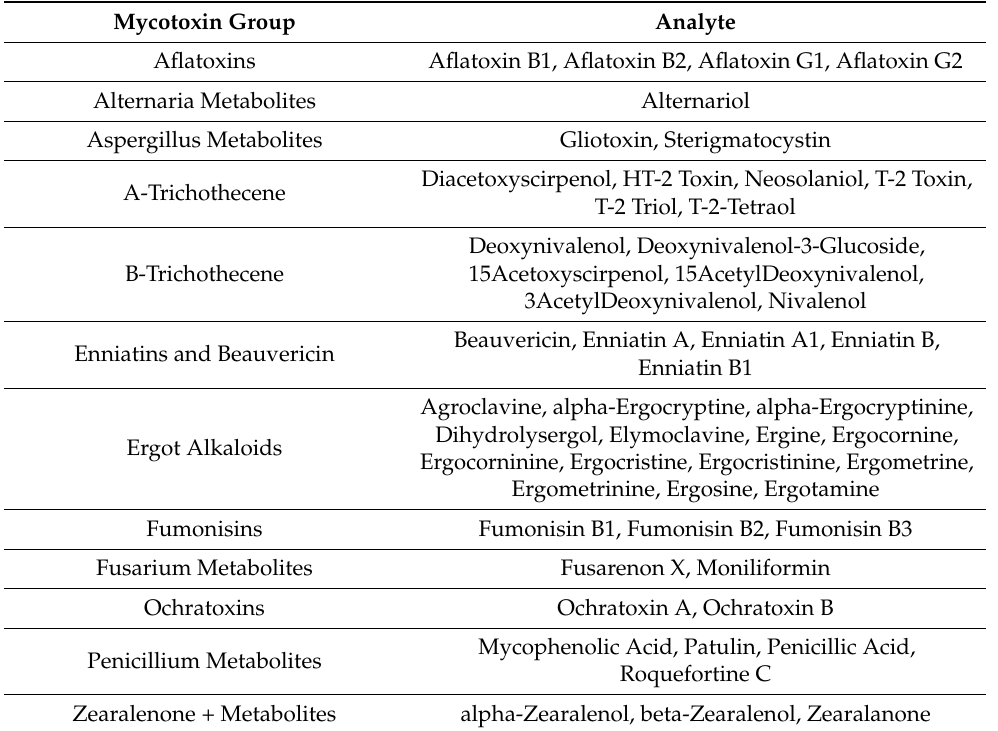
Table 1. Mycotoxin groups and analytes analyzed by